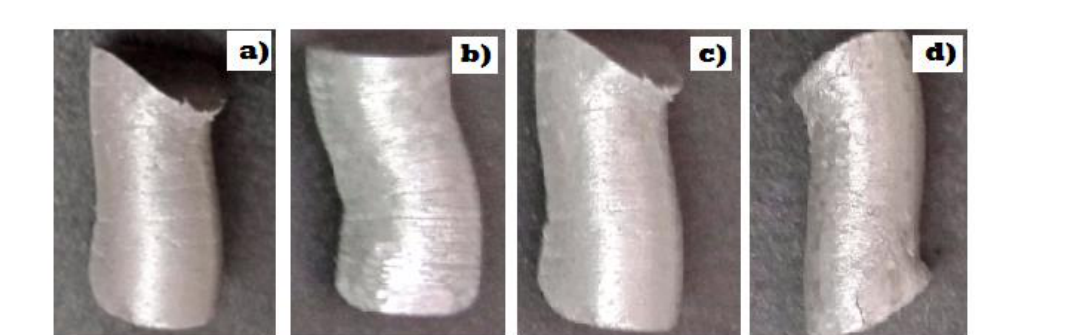
Figure 18. Images of compressive strength test specimens having ( a ) 0% ( b ) 5% ( c ) 10% ( d ) 15% ZrO 2 particulates for 13 wt.% Si.